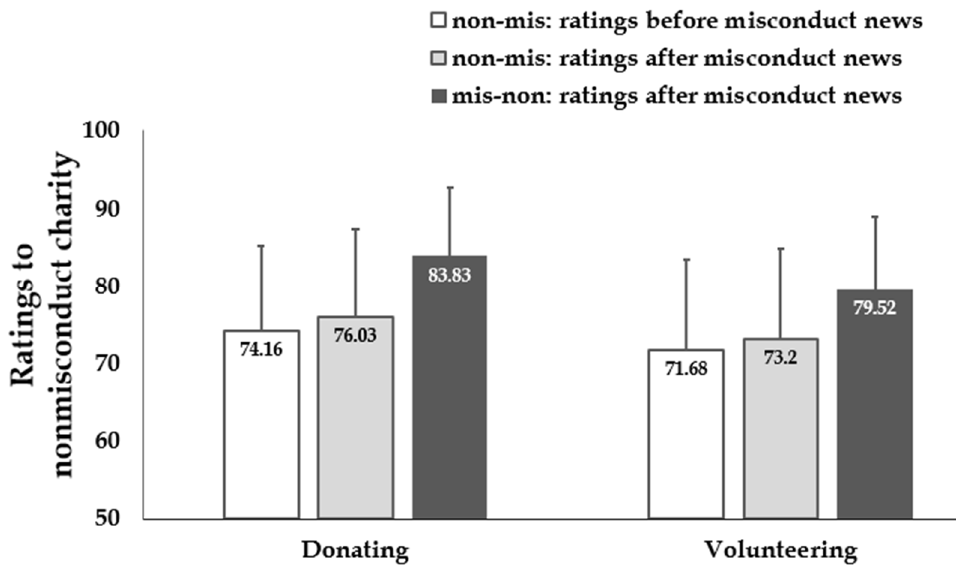
Figure 5. Results in Study 4. Donating and volunteering ratings to the nonmisconduct charity after reading misconduct news (mis-con condition) are significantly higher than ratings before reading misconduct news (non-mis condition) and ratings after reading misconduct news (non-mis condition). Error bars: SD.